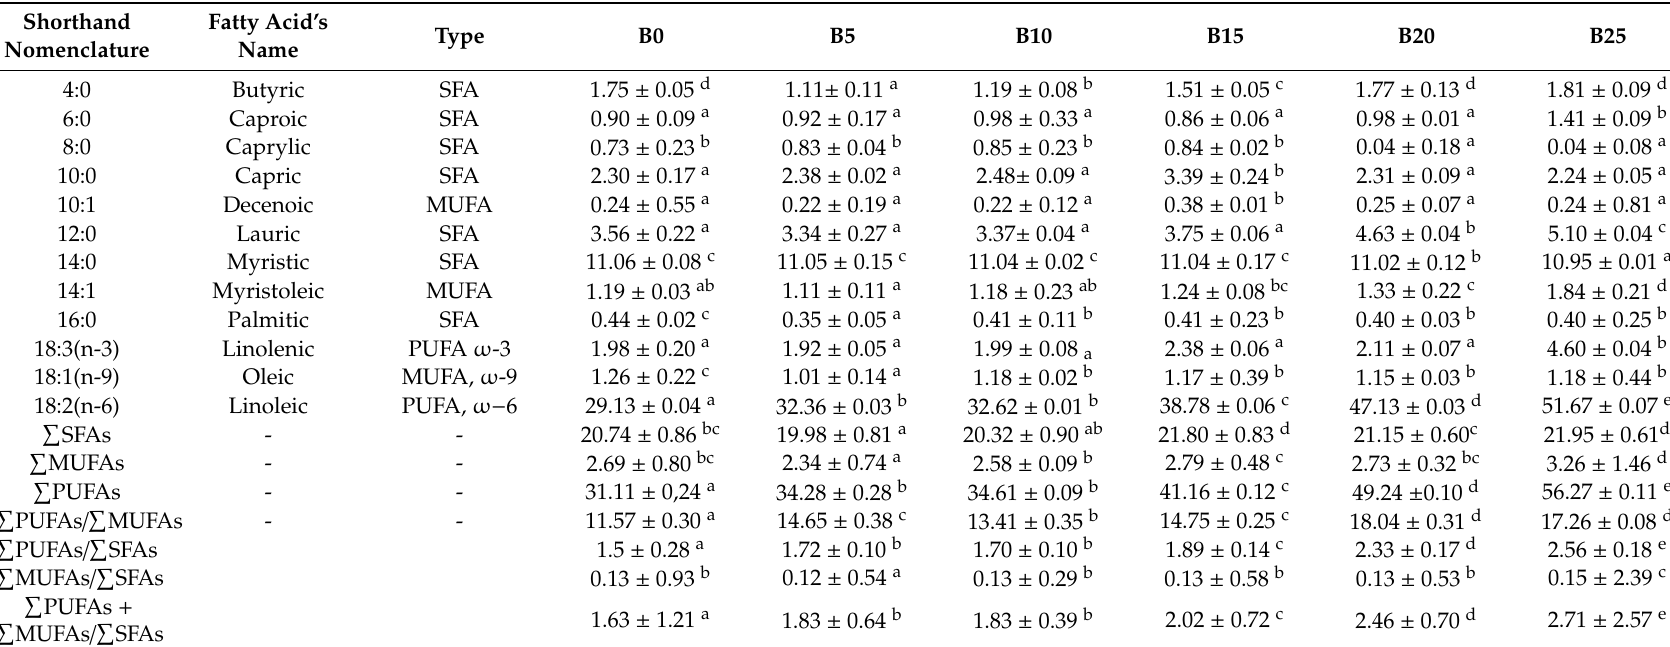
Table 4. Fatty acids methyl esters content (% of total fatty acids methyl esters) in enriched biscuits with spent malt rootlets in di ff erent